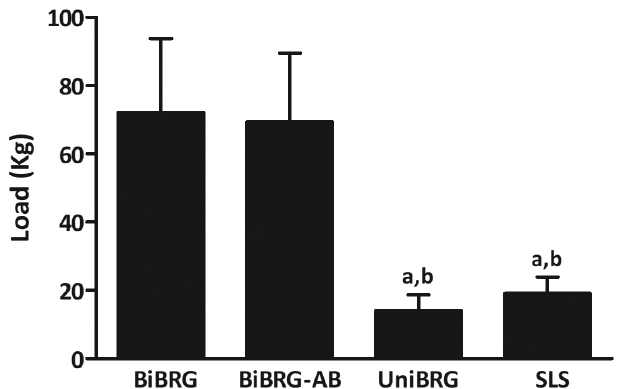
Figure 3. Load (Kg) during 10RM (mean±SD) of bilateral supine bridge (BiBRG), bilateral supine bridge with hip abducted (BiBRG-AB), unilateral supine bridge (UniBRG) and single-leg squat (SLS). a – different of BiBRG; b – different of BiBRG-AB